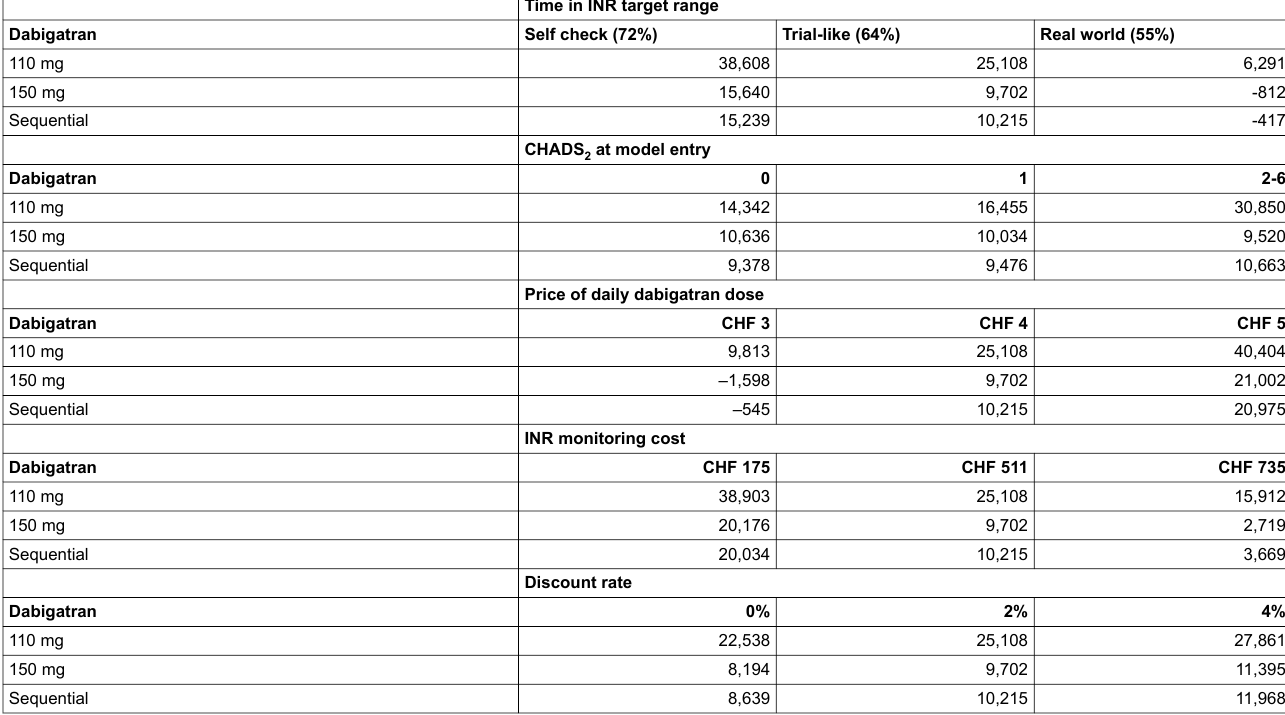
Table 7: Univariate sensitivity analysis of the ICER in the three dabigatran dosage scenarios versus VKA. The univariate sensitivity analysis shows how the ICER (CHF/ QALY) changes when single model parameters are modified. The central column contains the ICERs of the base case